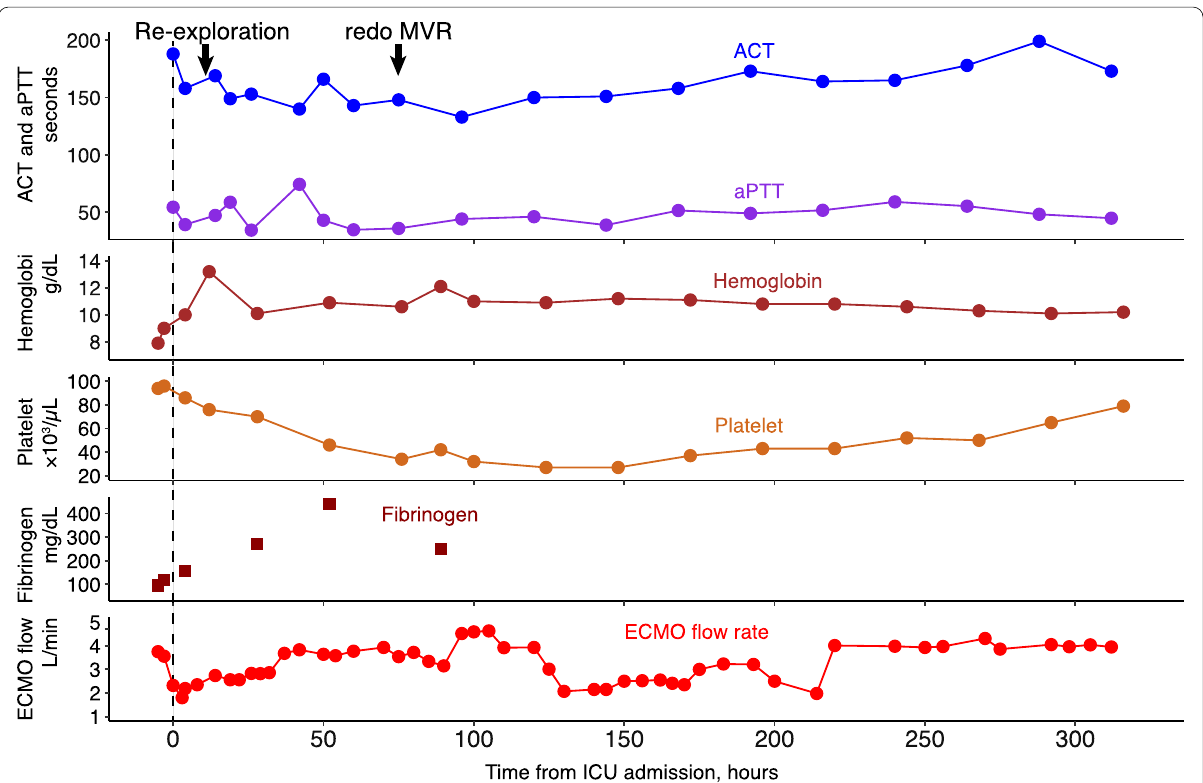
Fig. 2 The changes in activated clotting time, activated partial thromboplastin time, extracorporeal membrane oxygenation flow rate, hemoglobin, platelet, and fibrinogen levels after the ICU admission. ACT, activated clotting time; aPTT, activated partial thromboplastin time; ECMO, extracorporeal membrane oxygenation; MVR, mitral valve